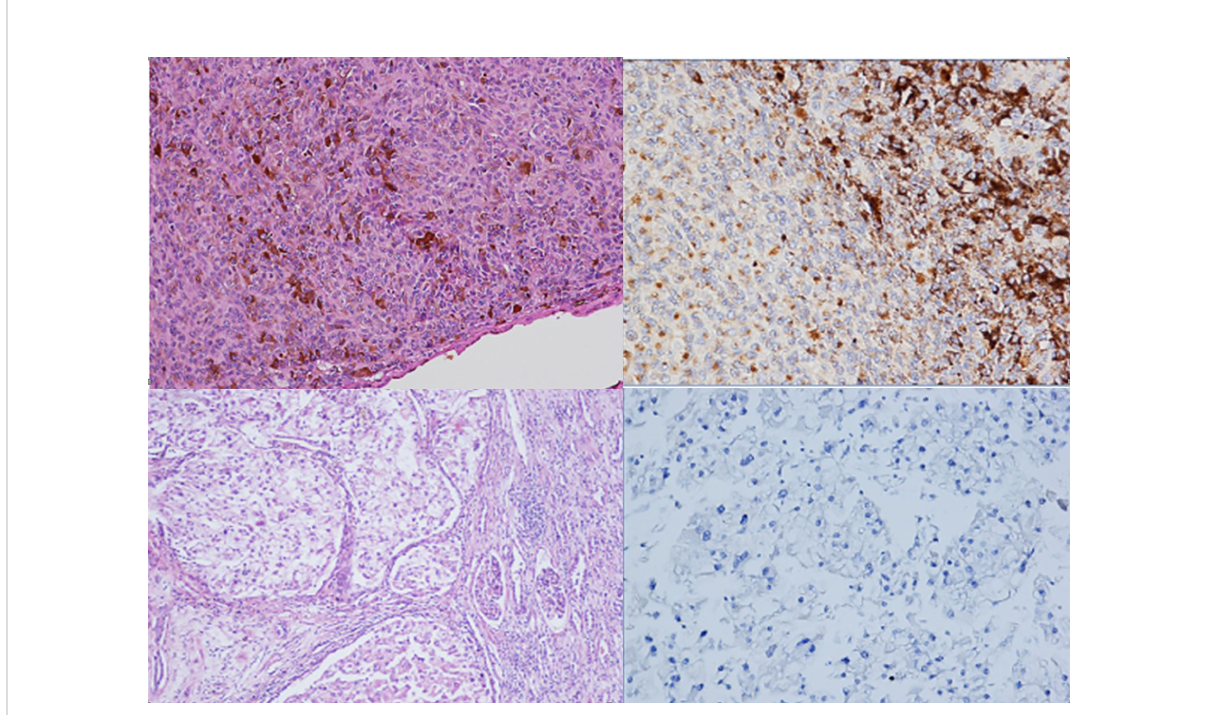
FIGURE 2 Histological examination of the pleural samples, showing a neoplastic proliferation composed of both epithelioid and spindle cells ( A , haematoxylin and eosin staining, 100x) that was immunoreactive for calretinin ( B , immunohistochemistry, 200x) and negative for BAP1 ( C , immunohistochemistry, 100x), with CDKN2A/p16 deletion visualized via FISH analysis (D)